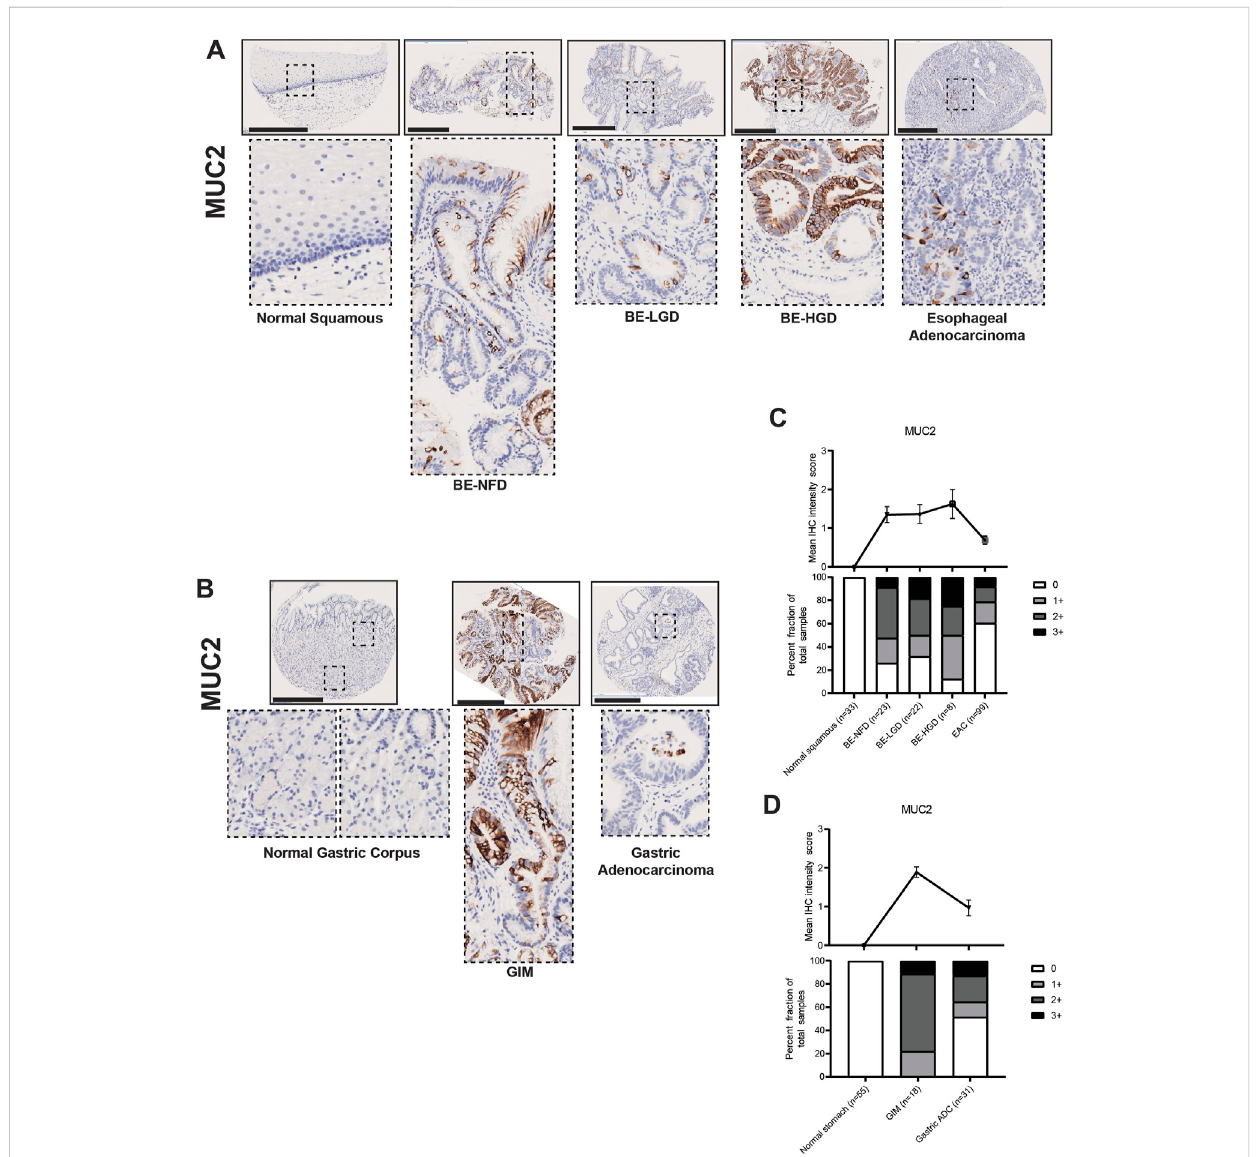
FIGURE 4 MUC2 expression in normal squamous-BE-EAC and normal gastric gland-GIM-GA progression sequence. (A) Immunohistochemistry of MUC2 staining in human tissue microarray esophageal cases, in the same sequence as in Figure 2A. (B) Immunohistochemistry of MUC2 staining in human tissue microarray gastric cases, in the same sequence as in Figure 2B. All scale bars, 500 μ m. (C) Top: the MUC2 average IHC intensity score of eachesophagealphenotypeisplotted inthesamesequenceasinFigure2C.Bottom: theMUC2 fractionofesophagealtissue coreswitheachscore is plotted in the same sequence as in Figure 2C. Each phenotype ’ s total tissue core number is provided at the bottom of each column. (D) Top: the MUC2 average IHC intensity score of each esophageal phenotype is plotted in the same sequence as in Figure 2D. Bottom: the MUC2 fraction of esophageal tissue cores with each score is plotted in the same sequence as in Figure 2D. Each phenotype ’ s total tissue core number is provided at the bottom of each